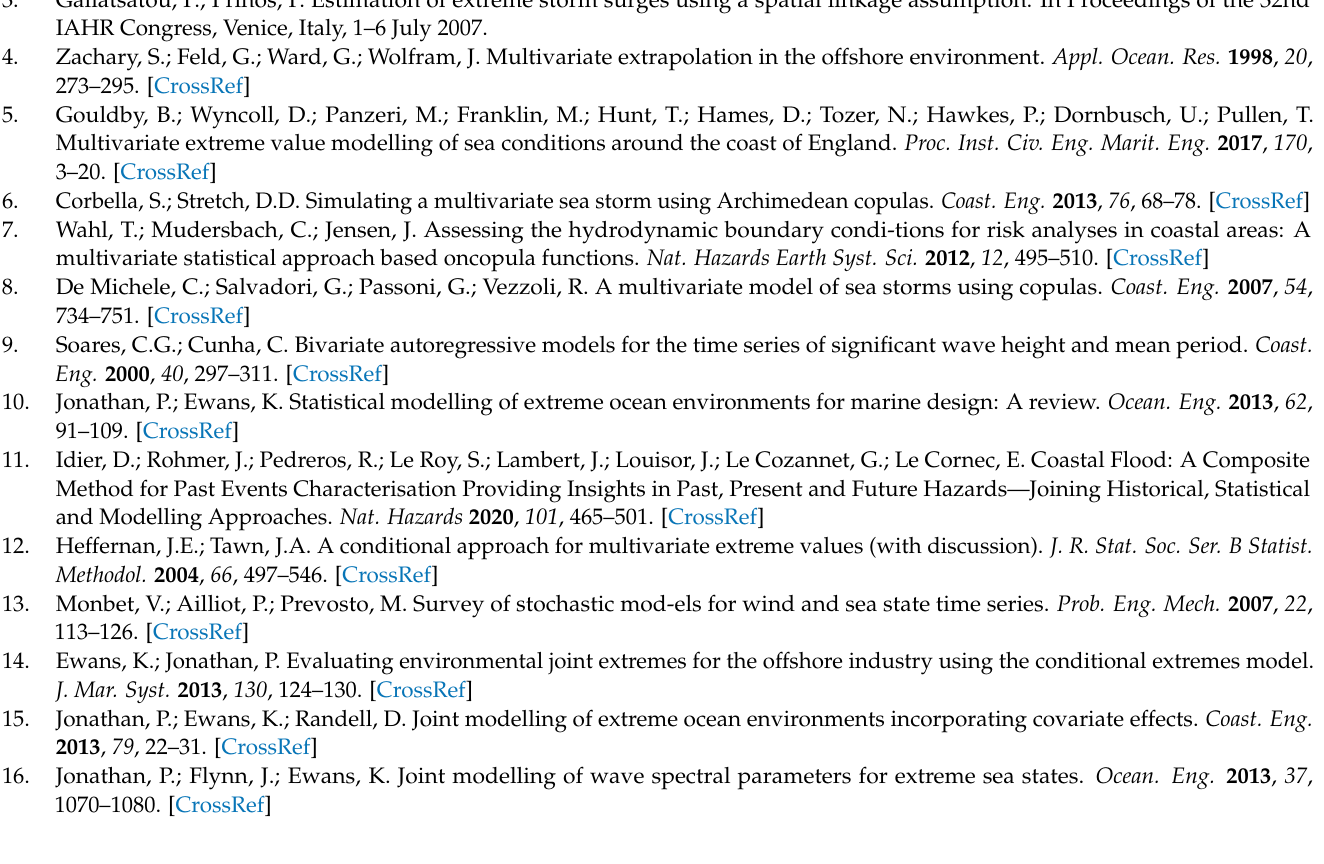
Figure A5. Dependence coefficients a and b, residuals Z for selected threshold ν for two coastal regions of Corsica.